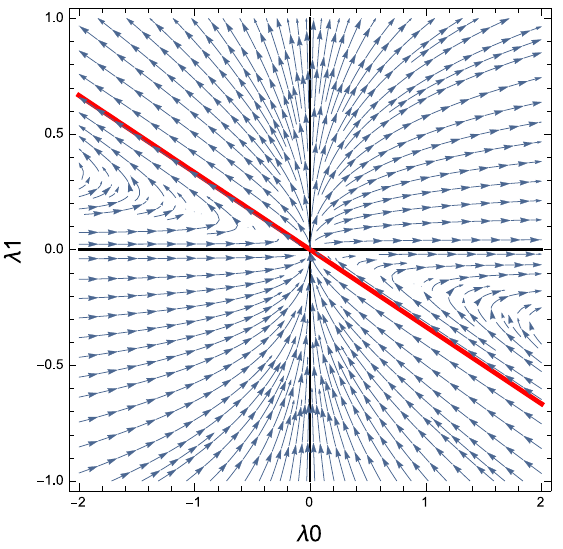
Figure 4 . Flow of the beta functions (3.11) and (3.12). Arrows point towards the IR. The red line is the locus (cid:21) 0 + 3 (cid:21) 1 =